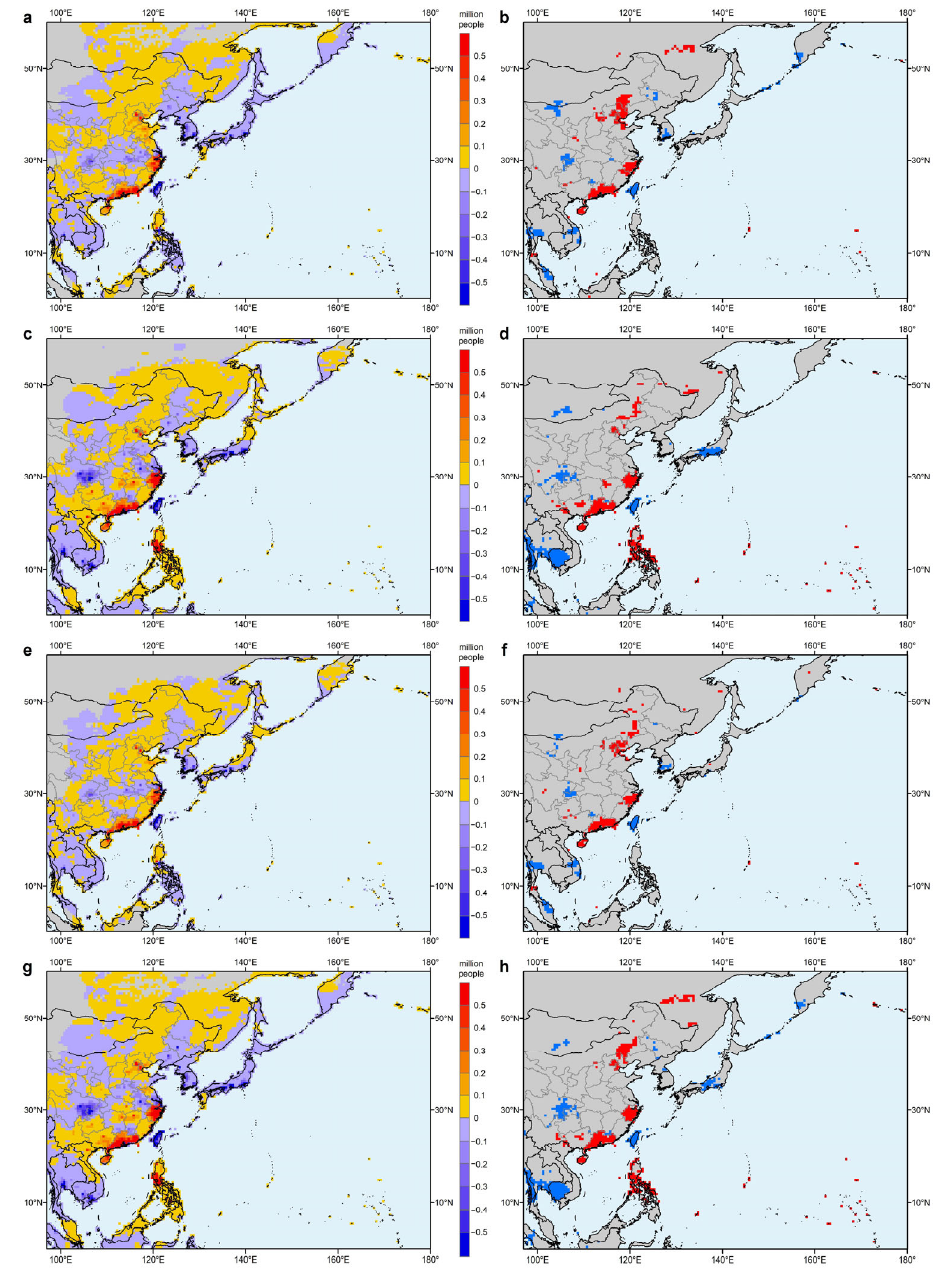
Figure 4. Spatial distribution of exposed population changes in the Northwest Pacific. ( a , c , e , g ): Spatial distribution of exposed population changes over the period 2015–2050 for tropical cyclone hazard scenarios I, II, III, and IV, respectively. ( b , d , f , h ): Regions with significant changes between periods are indicated in red (increased) and blue (decreased) at the 95% confidence level for tropical cyclone hazard scenarios I, II, III, and IV, respectively.